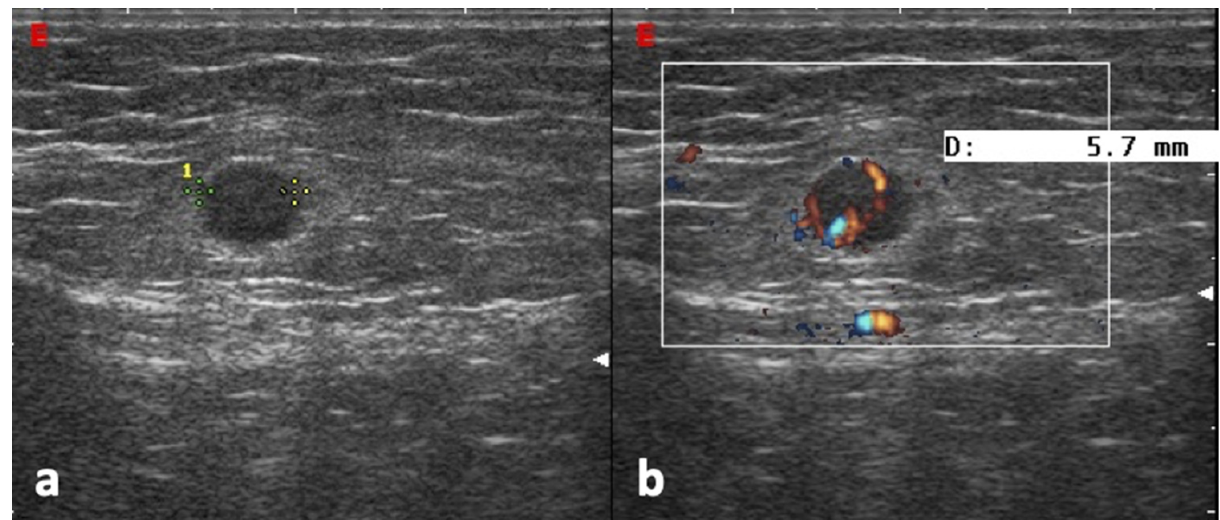
Figure 3. Epitrochlear lymphadenopathy from cutaneous melanoma of the elbow. The B-Mode US scan ( a ) shows a round, hypoechoic, and heterogeneous lymph node with irregular borders. The color Doppler scan ( b ) shows an intense and anarchic vascularity. Regarding color and power Doppler sonography evaluation, in metastatic lymph nodes, the hilar region, which is normally centrally localized, may be dislocated or small in size, and may even disappear (Figure 2) [32].